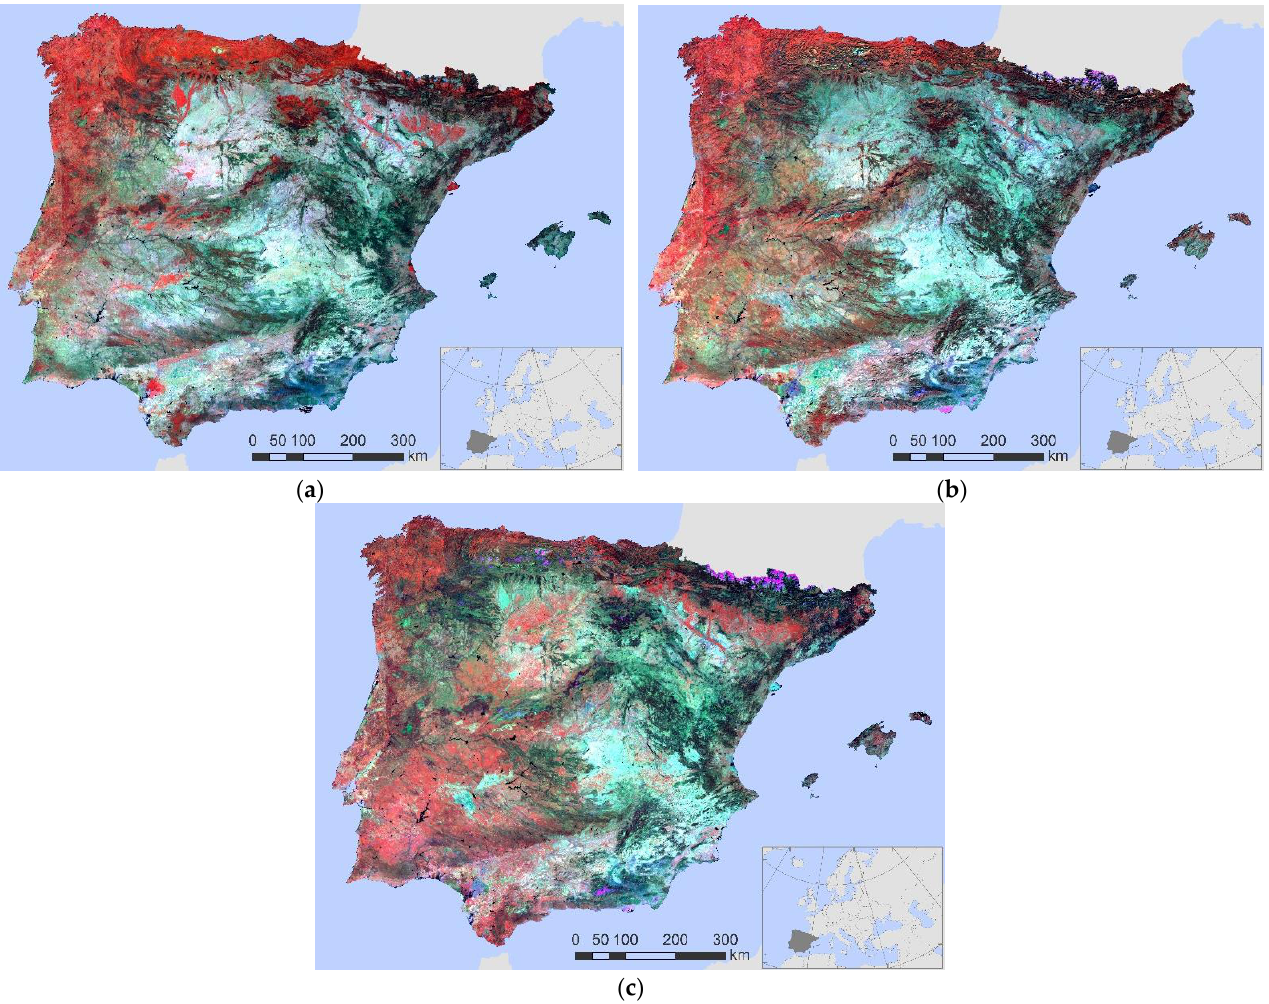
Figure 3. (a) Summer 2020, (b) autumn 2020, and (c) spring 2021 mosaics for the Iberian Peninsula and the Balearic Islands Figure 3. ( a ) Summer 2020, ( b ) autumn 2020, and ( c ) spring 2021 mosaics for the Iberian Peninsula and the Balearic Islands in RGB colour composition (865, 2250, and 659 nm) from the Sentinel 3 Synergy images. in RGB colour composition (865, 2250, and 659 nm) from the Sentinel 3 Synergy